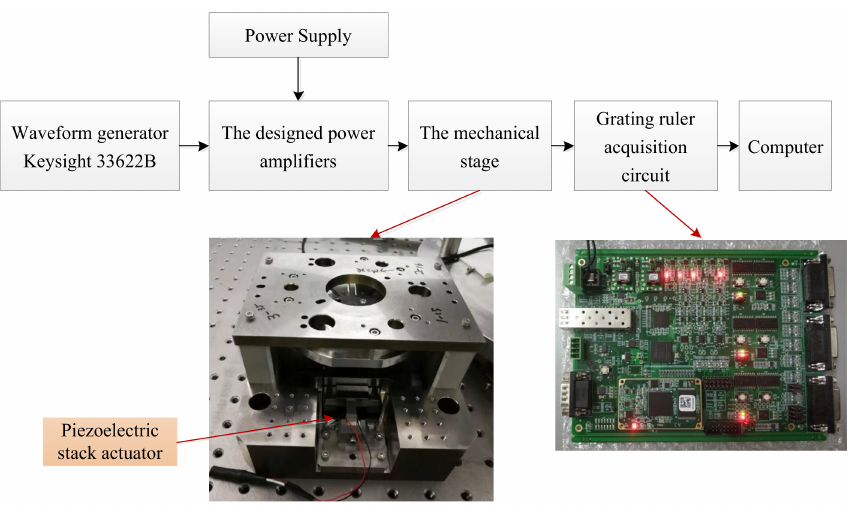
Figure 30. The tests with the mechanical